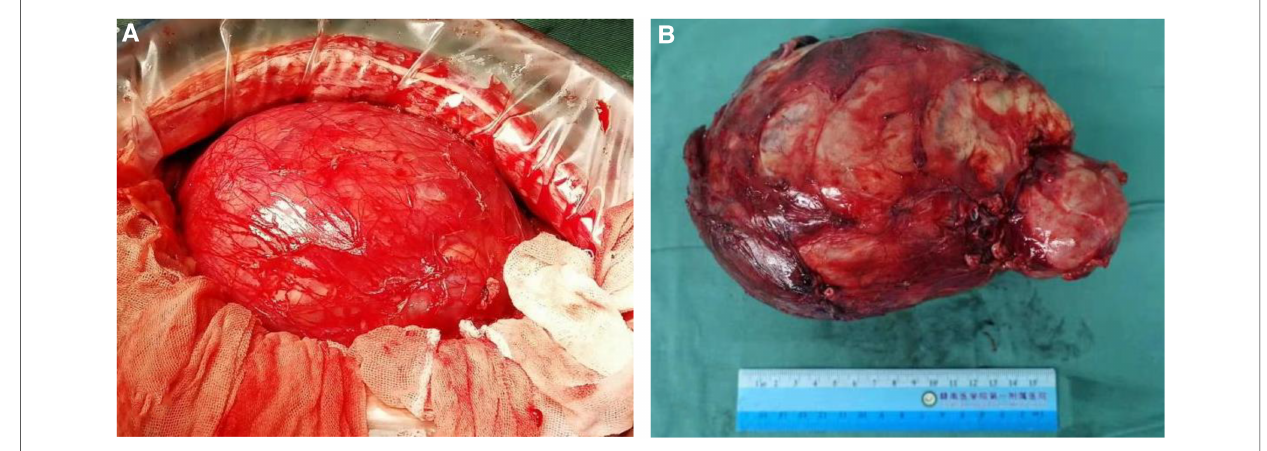
FIGURE 2 A radical resection of the left kidney was performed, and gross specimens of the tumor were obtained. The tumor was located at the lower pole of the left kidney with clear boundaries and no adhesion ( A ), large tumor in the lower pole of the left kidney, and the surface is smooth and locally cystic ( B ).